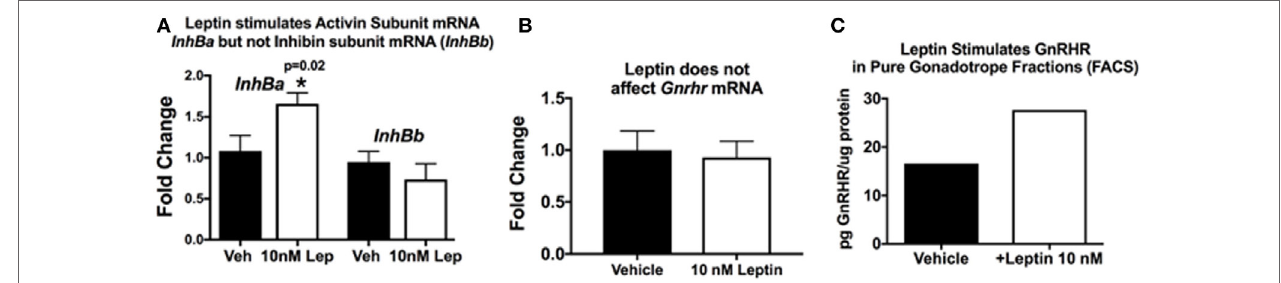
FiGUre 3 | Pituitary responsiveness to leptin: activin and gonadotropin releasing hormone receptor (GnRHR). (a,B) Individual pituitaries were placed in 400 μ L DMEM with protease inhibitor cocktail and ITS supplement (Sigma), with or without 10 nM recombinant mouse leptin (Sigma). The pituitaries were triturated two times with a 26 G needle and syringe. The pieces incubated for 3 h at 37°C, followed by mRNA extraction as previously described [(33)]. cDNAs were assayed by real-time PCR for the levels of activin/inhibin subunit (a) and Gnrhr (B) mRNA levels. Leptin stimulates an increase in pituitary activin subunit mRNA ( InhBa ) level and does not have an effect on inhibin ( InhBb ) or Gnrhr mRNA levels. (C) In a separate set of experiments, we used fluorescence-activated cell sorting (FACS) to purify gonadotropes from control females bearing Lh-cre and floxed alleles of tdTomato-eGFP as described previously (126). The Cre-recombinase ablates the tdTomato leaving eGFP to be expressed in membranes of gonadotropes. Our analysis showed that the eGFP fraction was 98–99% gonadotropes by immunolabeling for LH and follicle-stimulating hormone (FSH). In this experiment, a female gonadotrope fraction containing 66,830 cells was split and half of the cells were stimulated for 3 h with 10 nM leptin. Protein extracts of these cells were assayed by EIA for GnRHR (127). (C) GnRHR proteins were higher in the gonadotropes stimulated with leptin (from 16.67 µg GnRHR/mg protein to 27.6 µg/mg protein). The amount of protein in the extracts did not allow for multiple samples and, therefore, there are no error bars. More details about the GnRHR assays are reported in Akhter et al., (33). Details about the FACS protocol can be found in Odle et al. (126,